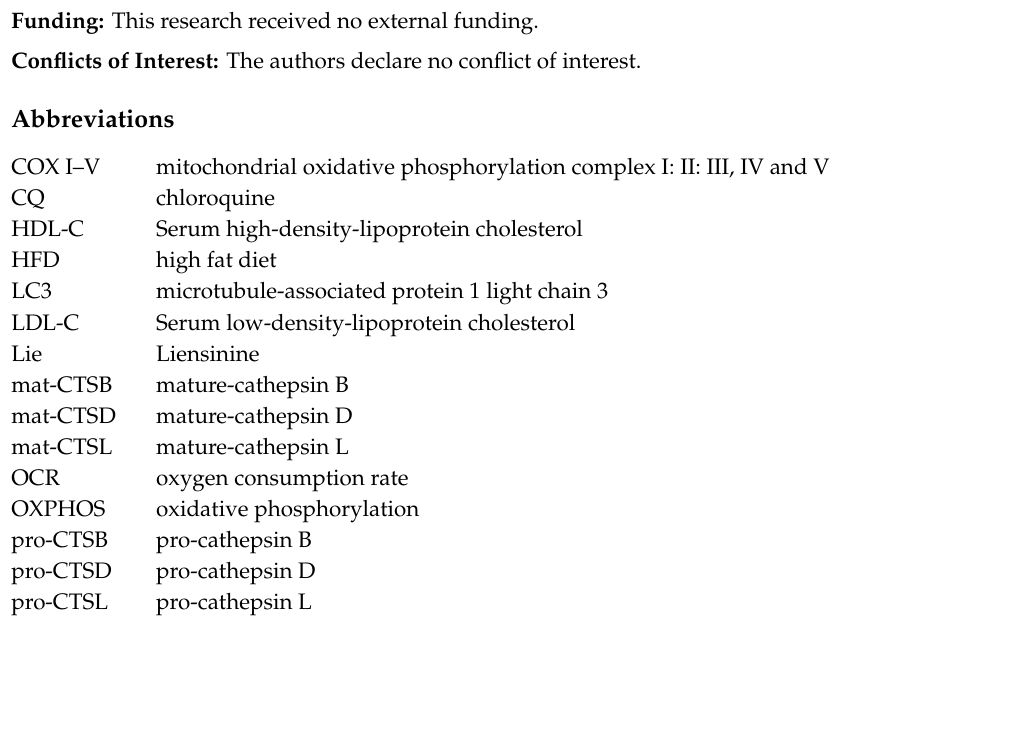
Figure S1: The basal OCR and the maximal OCR in the control, beige adipocytes and beige adipocytes at day 5 following Rosi withdrawal. The basal OCR and the maximal OCR in Beige adipocytes exposed to various concentrations (0, 10 and 40 µ M) of Lie for 5 days after Rosi withdrawal. Figure S2: Spontaneous activity during a 12 h light-dark cycle was measured by